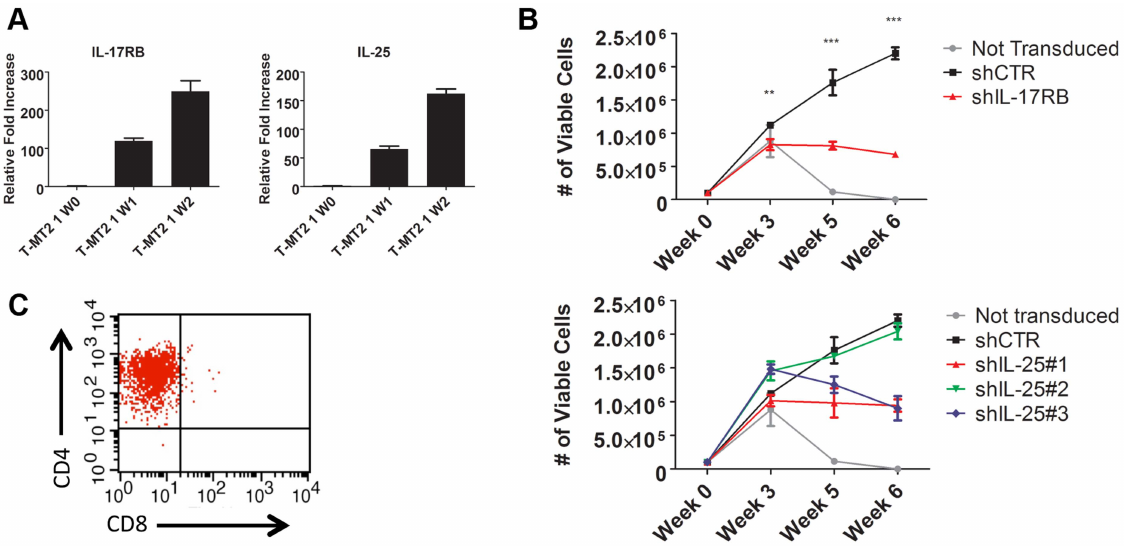
Figure 4. IL-17RB and IL-25 are essential for the HTLV-1-induced immortalization of T cells. ( A ) qRT-PCR of IL-17RB and IL-25 mRNAs in primary T cells co-cultured with lethally irradiated MT-2 cells after 0 (W0), 1 (W1) and 2 (W2) weeks. ( B ) In vitro immortalization assay using PBMCs transduced with lentiviruses expressing control (CTR), IL-17RB or IL-25 shRNAs and co-cultured with lethally irradiated MT-2 cells. ( C ) Flow cytometric analysis of CD4 and CD8 markers using immortalized PBMCs expressing control